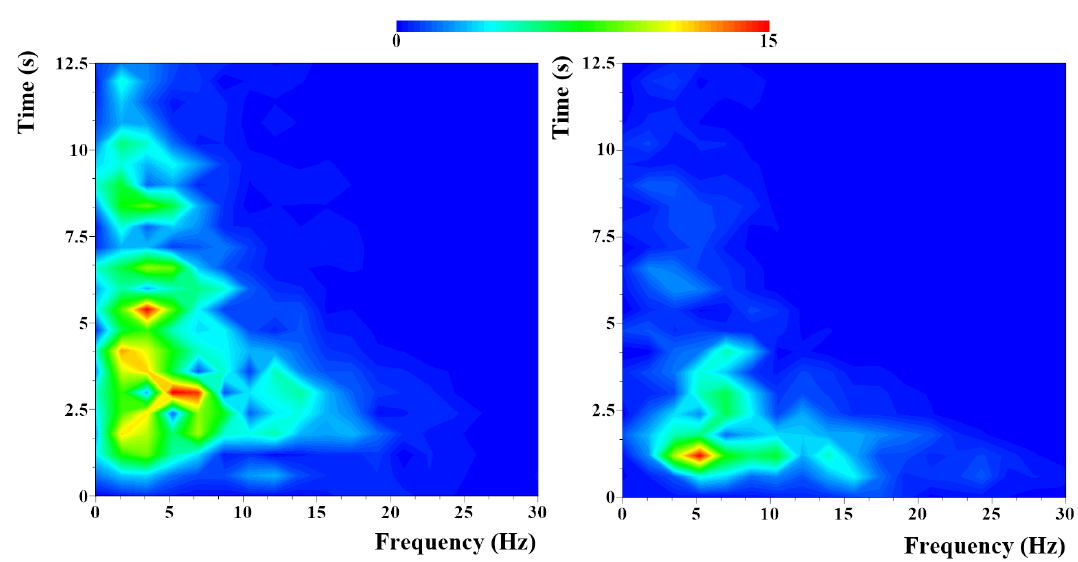
Figure 1: Comparison of spectrograms for mining-induced high-energy tremors with energy of 1.9 × 10 9 J (left) and 1.2 × 10 7 J